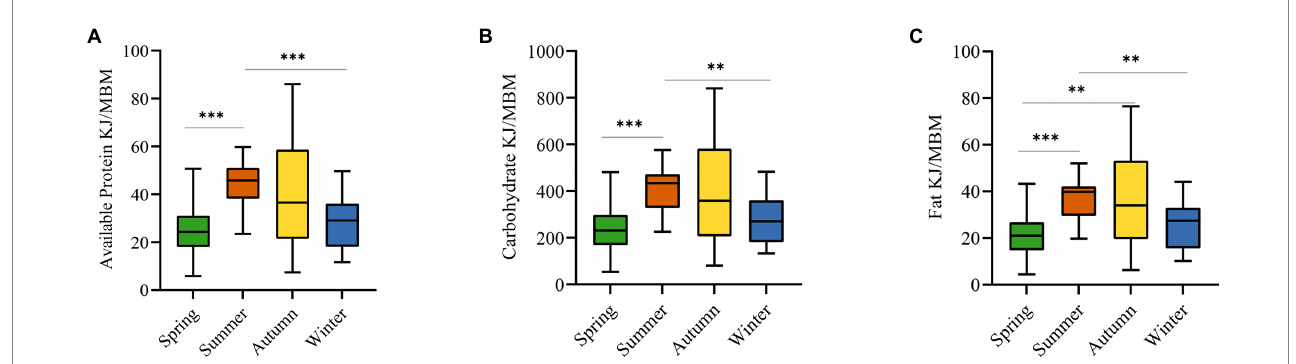
FIGURE 1 Comparison of macronutrients among four seasons (we measured the energy of metabolic body mass (KJ/MBM) provided by macronutrients). (A) The comparison of available protein intake. (B) The comparison of carbohydrate intake. (C) The comparison of fat intake. ** p < 0.01, *** p < 0.001. (Kruskal-Wallis test).